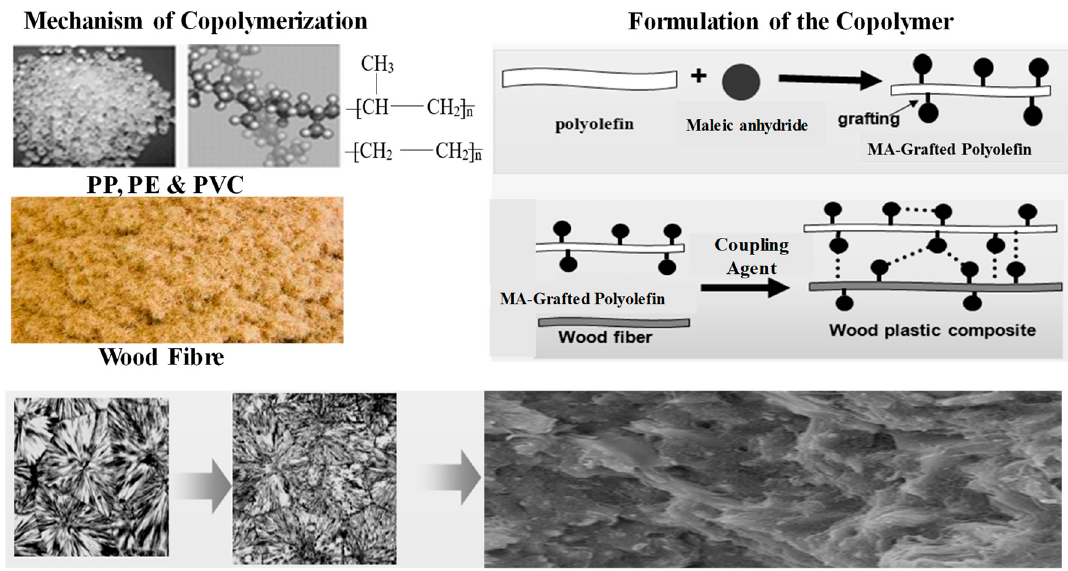
Figure 3. Multi copolymer technology; analysis and formulation mechanism of the copolymerization.